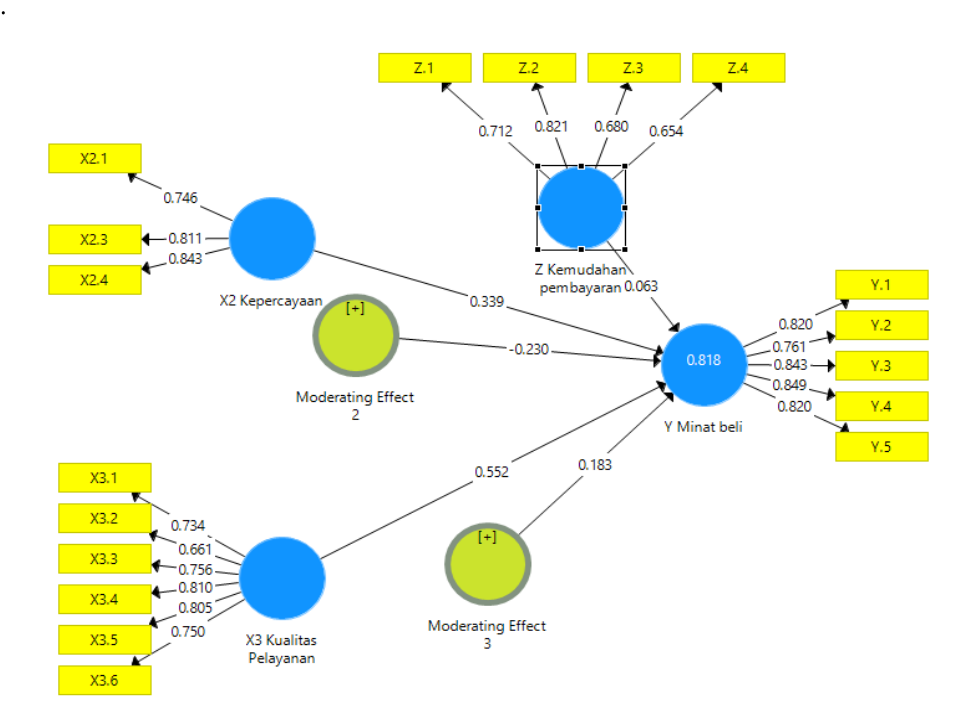
Figure 2. Figure of Discriminant Validity (Outer Loading)